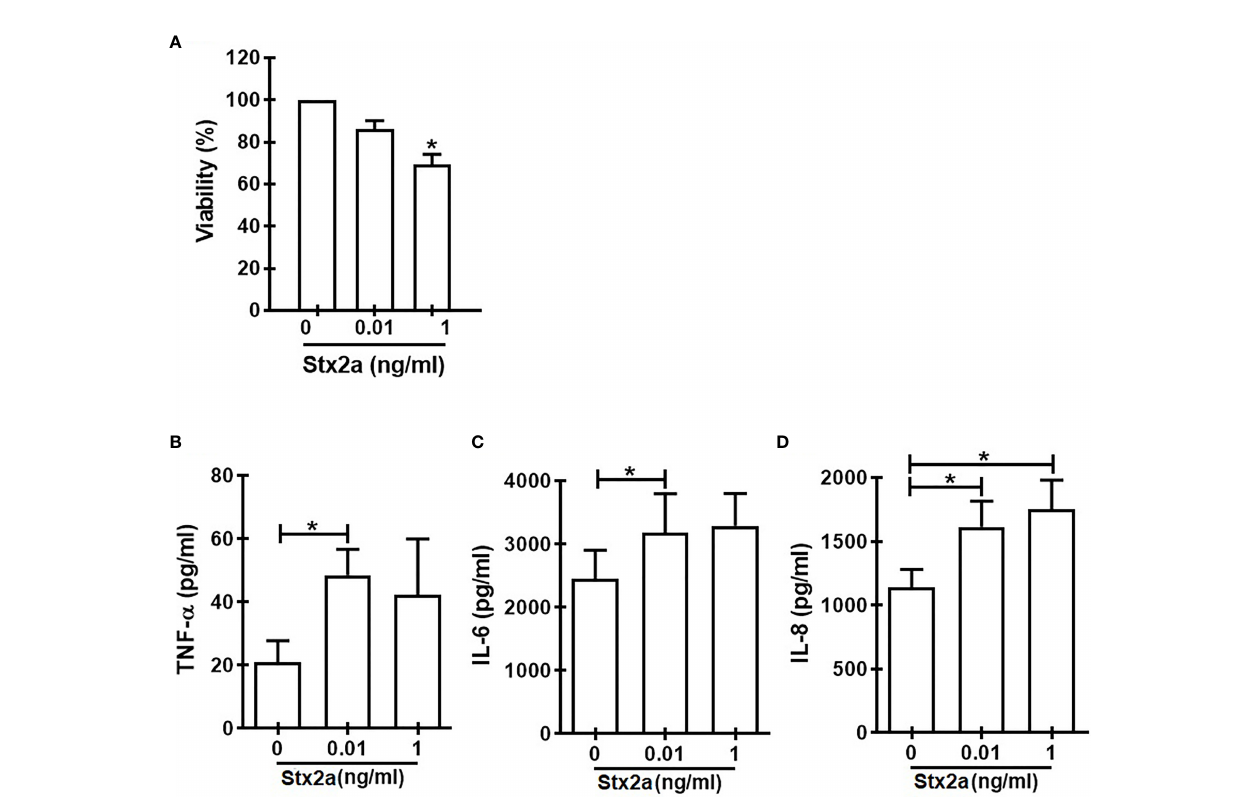
FIGURE 3 | Cytokine secretion by HGEC in response to different concentrations of Stx2a. Con fl uent monolayers of HGEC were stimulated with different concentrations of Stx2a (0.01 and 1 ng/ml) for 24 h. After incubation, cell supernatants were recovered. (A) Percentage of cell viability analyzed by neutral red uptake (n=3, biological replicates). Friedman with the Dunn ’ s multiple comparisons posttest. (B) TNF- a , (C) IL-6, and IL-8 (D) production measured by ELISA in cell supernatants, n=6 (biological replicates). Friedman with the Dunn ’ s multiple comparisons posttest. Results are shown as the mean ± SEM. * p <